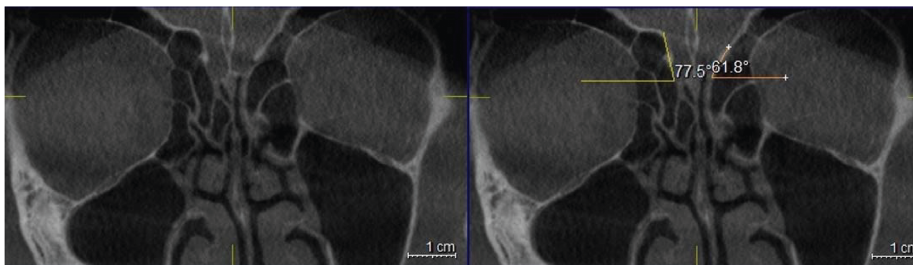
Figure 5: Coronal plan of CBCT demonstrating type II Gera classification on both sides.